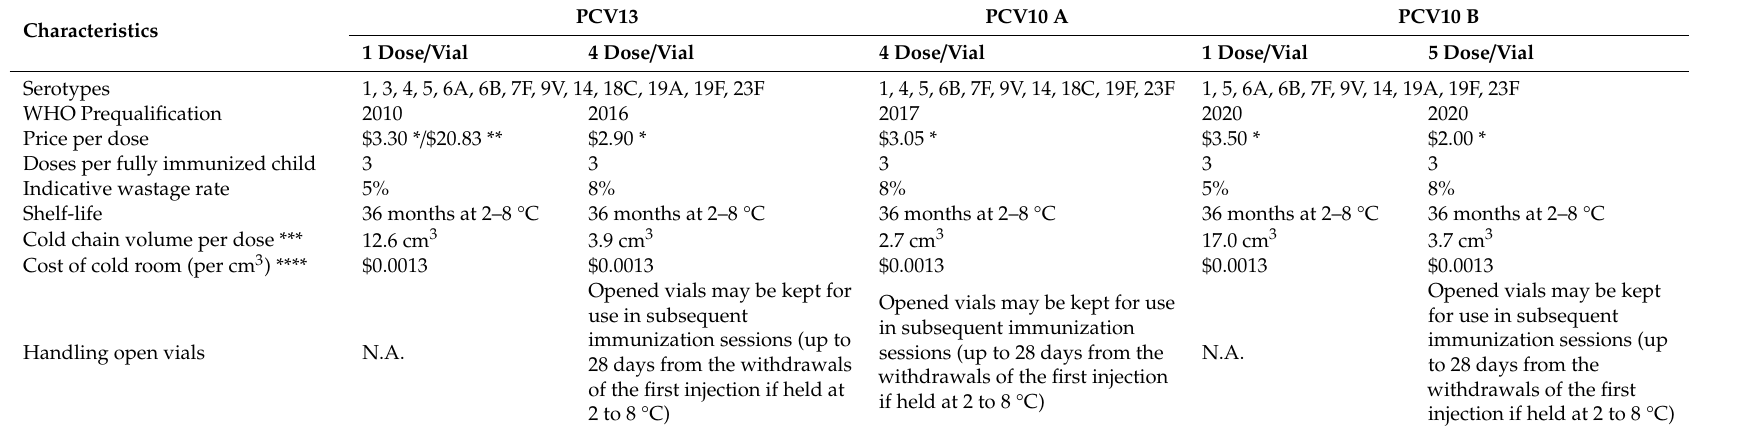
Table 1. Characteristics of pneumococcal conjugate vaccines (PCVs; PCV13, PCV10 A and PCV10